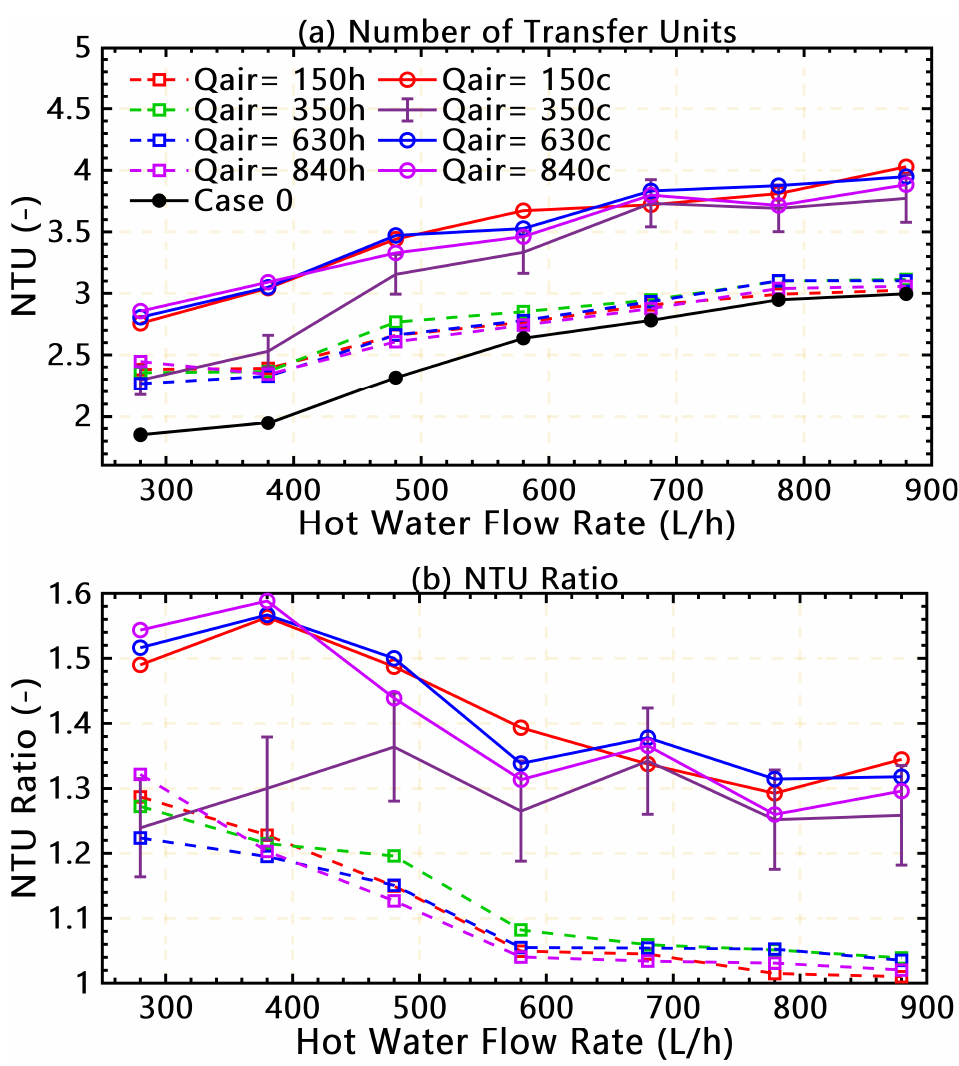
Figure 7. Relationship between ( a ) NTU and ( b ) NTU Ratio vs. Q h at different operating conditions for the original case (without ABI); and with ABI into CWS, HWS.